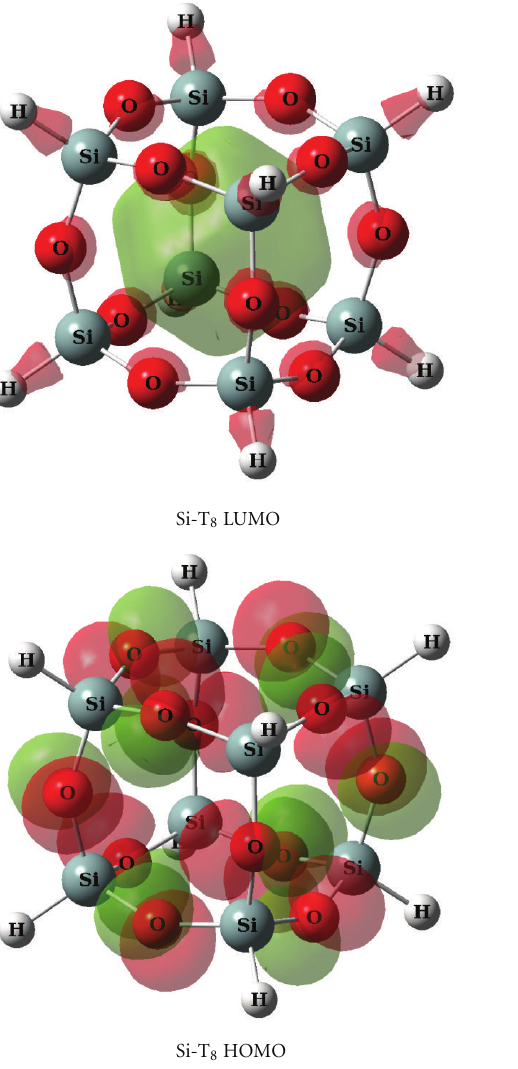
Figure 1: The HOMO and LUMO of T 8 and Ti-T 8 at the B3LYP/6-311+G(d)